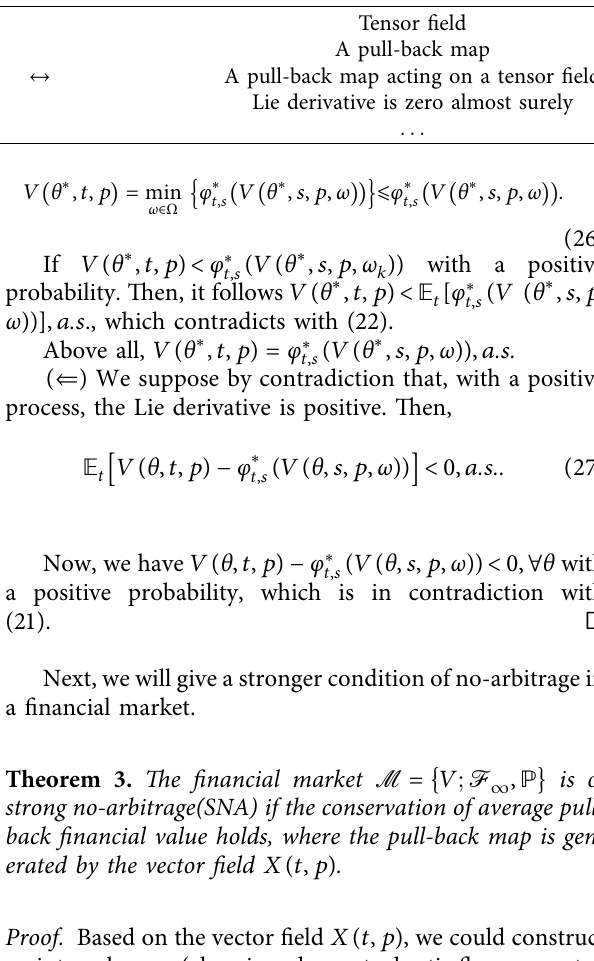
Table 1: Te correspondence between fnance and geometry.